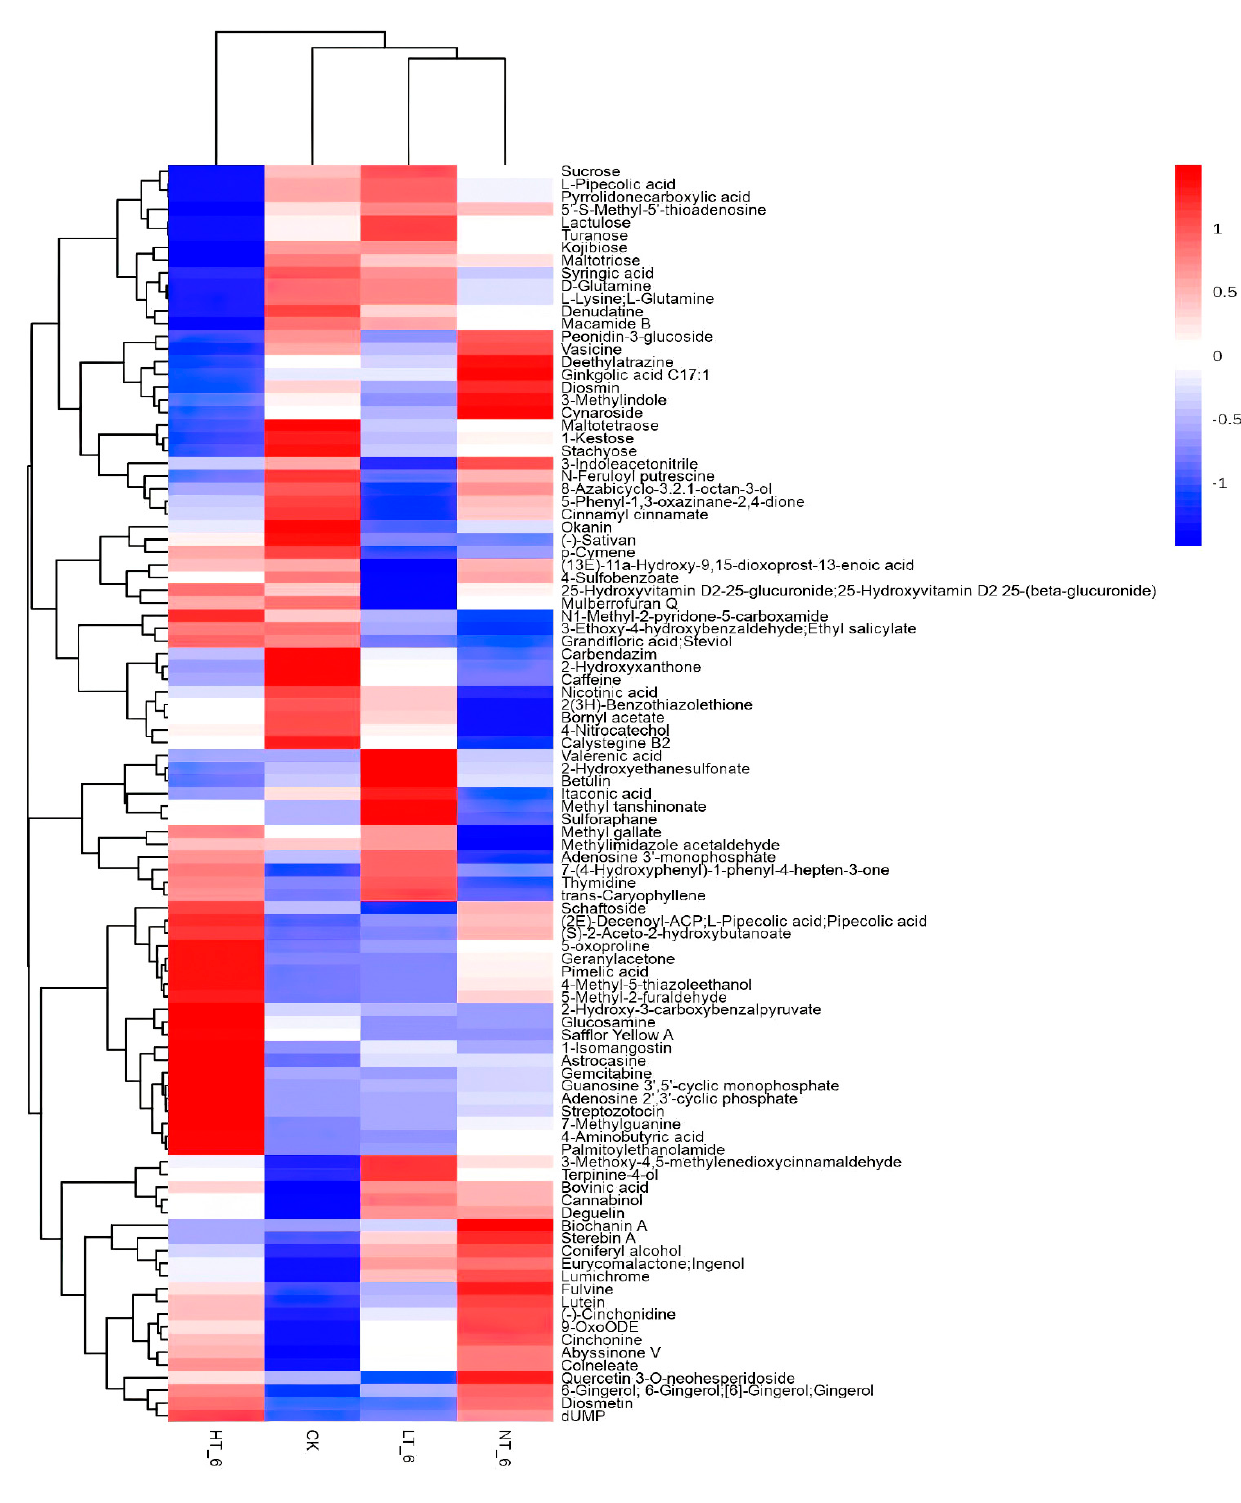
Figure 5. Hierarchical cluster analysis heatmap for all the experimental groups. The abscissa in the figure represents different experimental groups, the ordinate represents the differential metabolites compared in the group, the color blocks of different positions represent the relative expression levels of the metabolites at the corresponding positions, with the red indicating high expression of the substance, and the blue indicating low expression of the substance.